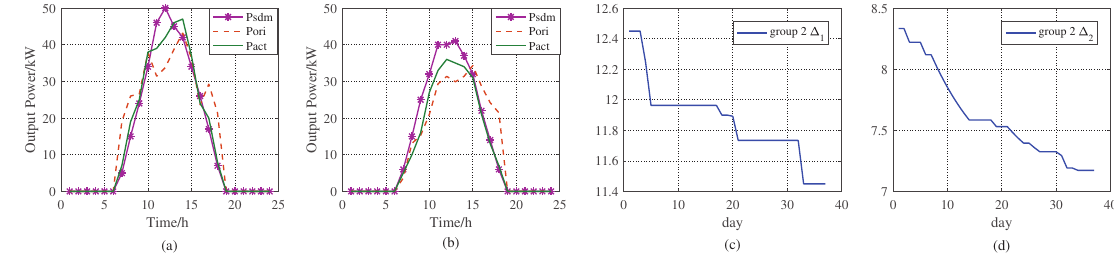
Figure 9. The results of group 1 in ASPF. ( a ) denotes that there is a similar day, and the MxAE between the actual solar power and historical value is less than ∆ 2 ; on the contrary, ( b ) shows the results that the MxAE is larger than ∆ 2 ; ( c ) plots a curve that the ∆ 1 in group 1 changes with the similar days’ message; ( d ) shows the ∆ 2 in group 1 changing with MxAE.